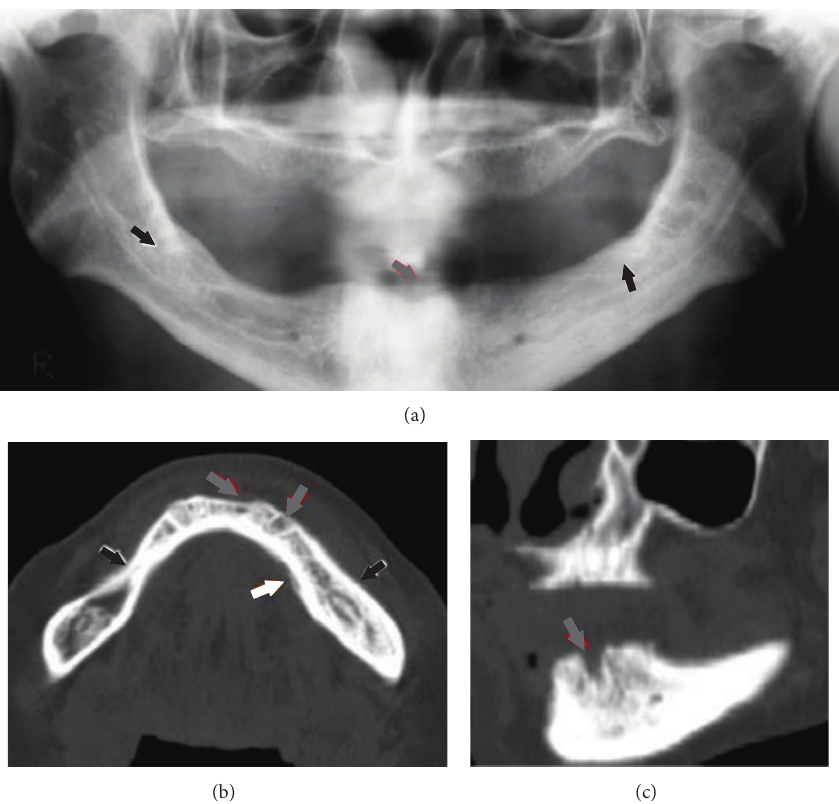
Figure 3: Imaging findings of a 65-year-old woman with metastatic breast carcinoma receiving intravenous zoledronic acid. (a) Panoramic radiograph showing an osteolytic lesion in the anterior mandible (gray arrow) and areas of osteosclerosis in the posterior regions (black arrows). (b) Axial CBCT image reveals areas of osteolysis (gray arrows), areas of osteosclerosis (black arrows), and a periosteal bone reaction in the left mandible (white arrow). (c) Sagittal CBCT image demonstrates a nonhealing extraction socket in the anterior